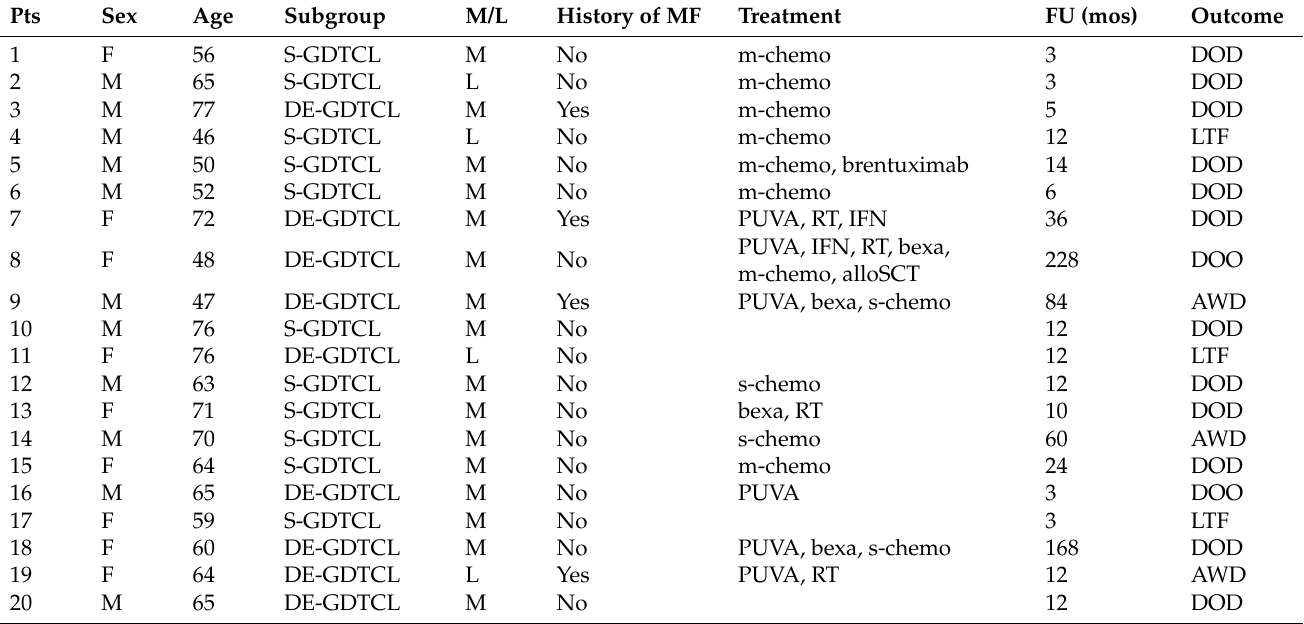
Table 1. Patients’ clinical